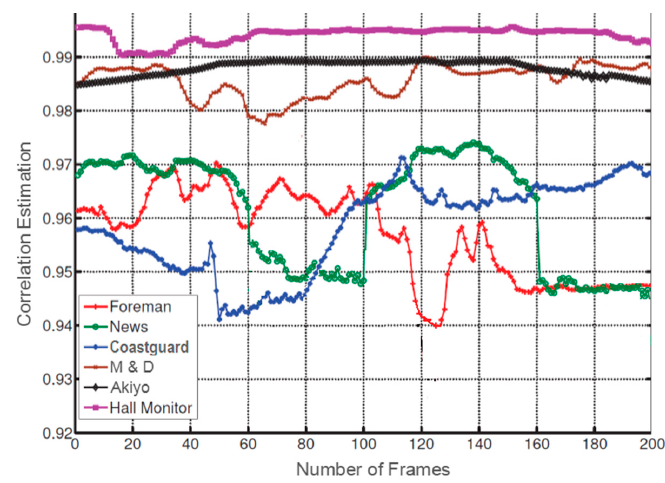
Figure 2. Correlation analysis of CS measurements among the adjacent frames of various CIF video sequences.